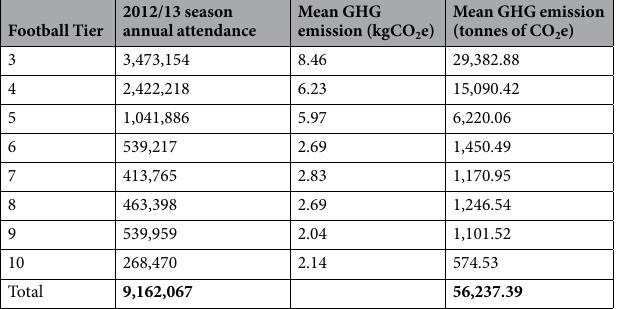
Table 4. National Extrapolation of GHG emissions for 2012/13 football season. Source: The annual attendance at football tiers 7, 23 , National emissions obtained by multiplying annual attendance at each tier by respective mean GHG